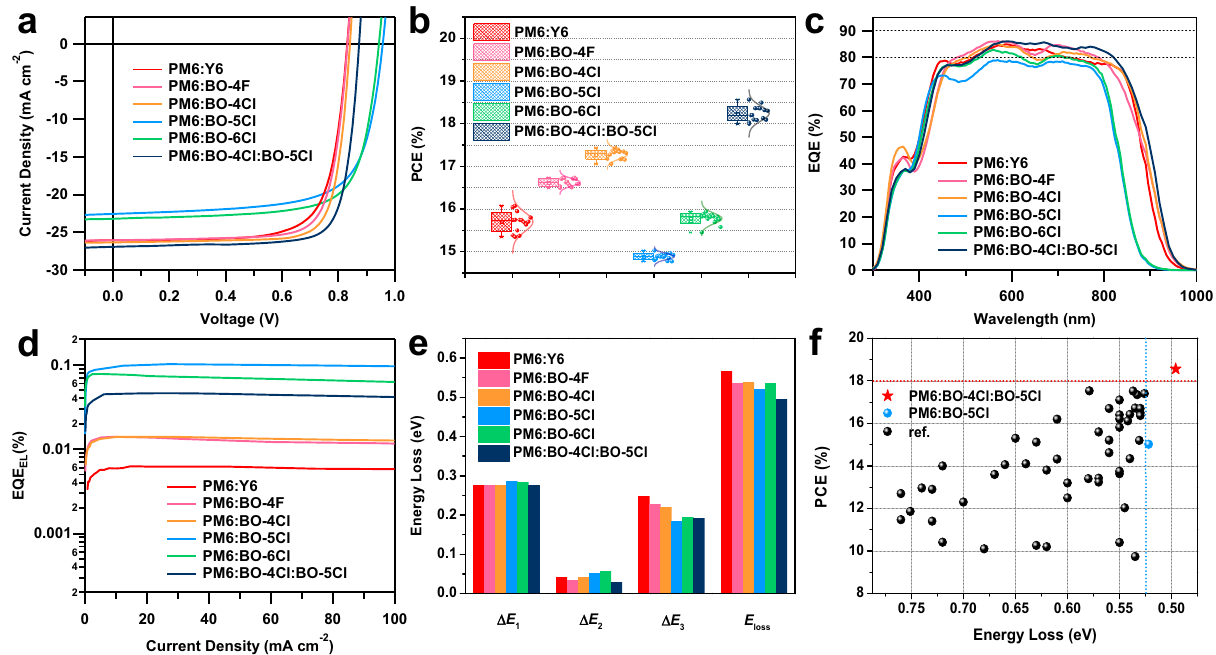
Fig. 5 Photovoltaic properties of OSCs. a J – V curves of the optimal devices. b PCE statistics (error bar is de fi ned as the standard deviation, which is calculated from the statistics results of 15 devices). c EQE curves and d EQEEL curves of the optimal devices. e Comparison of energy loss in the six types of devices. f Comparison of ef fi ciency and energy loss between this work and earlier references (original data in Supplementary Table 16).